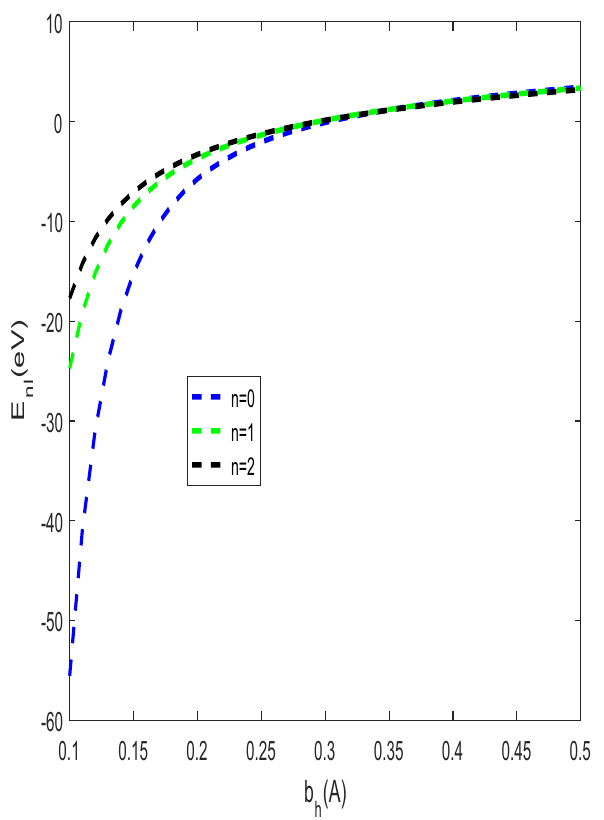
Figure 3. Energy E n , ℓ against the b h with µ = (cid:31) = ℓ = 1, b = 0.001 Å, C h = 0.95, r e = 0.5 Å and D e = 10